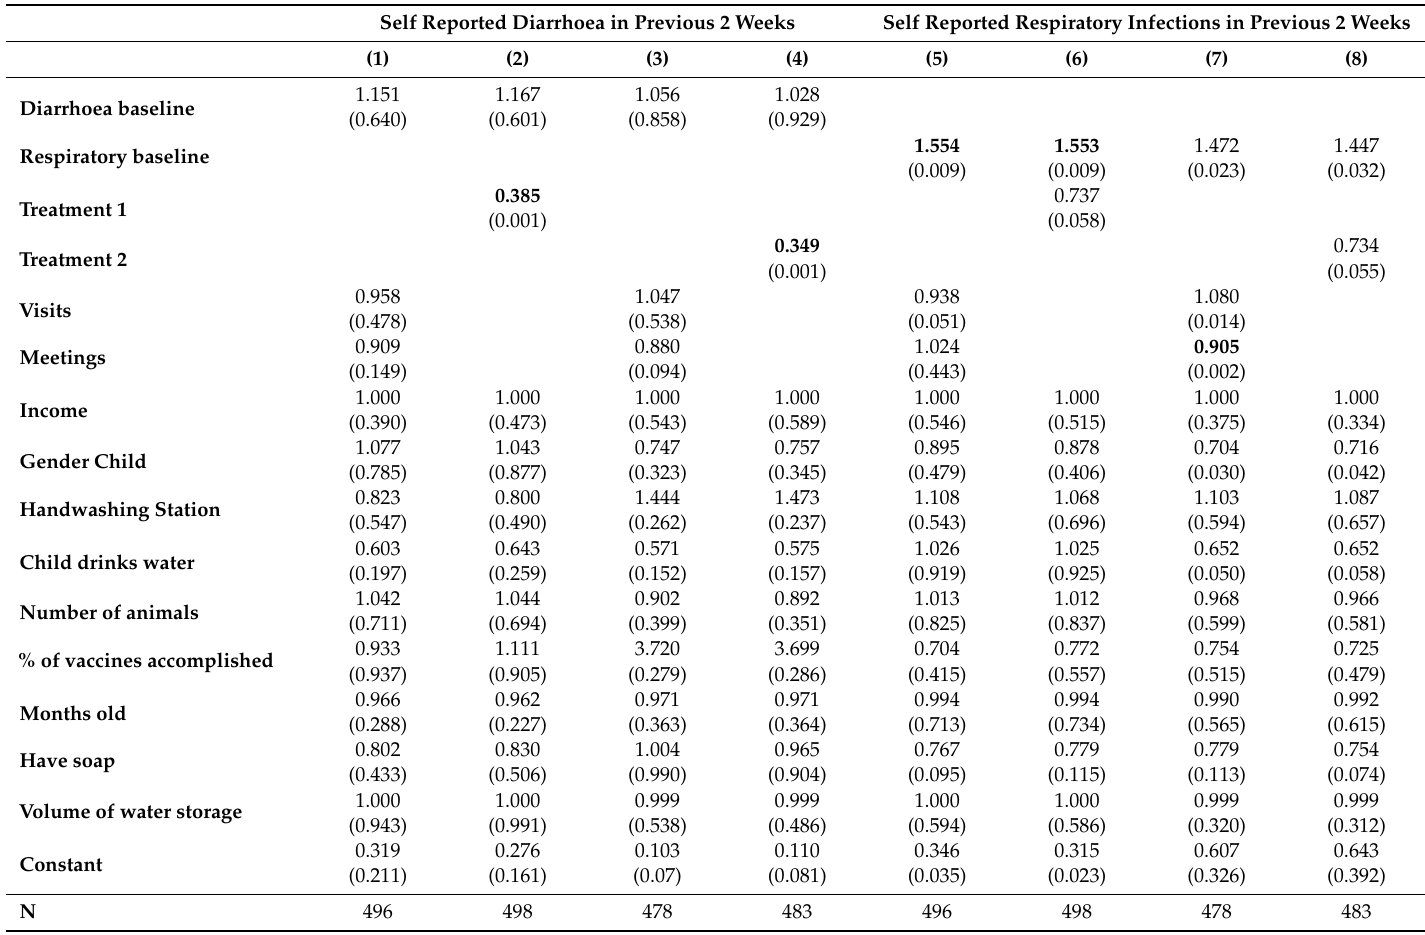
Table A1. Logistic Regression Results (Relative Risk Values) ( p -values in parentheses; significant figures in